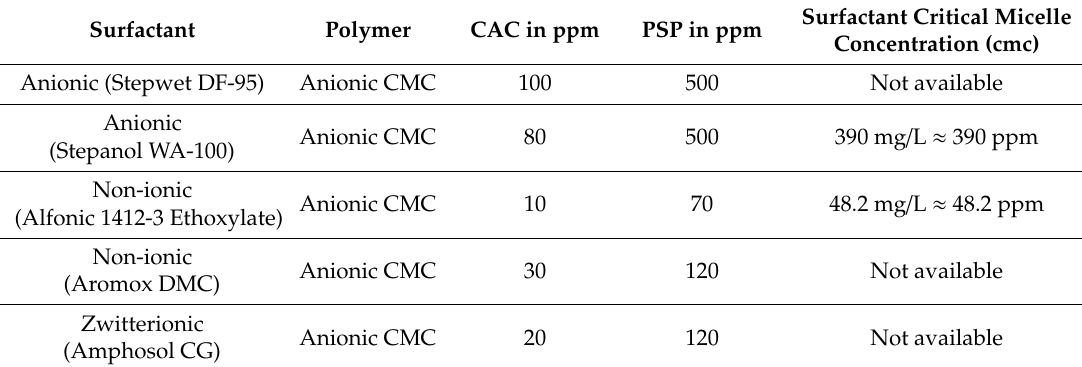
Table 2. Summary of approximate values of CAC and PSP for different surfactants.